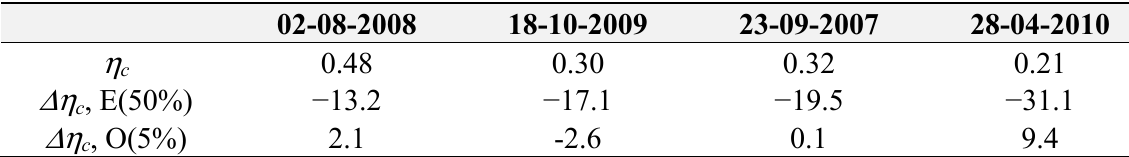
Table 3. The original values of the coarse volume mode fraction ( η selected days using the AERONET-retrieved size distribution and Equation (2) (top row). (%) caused by a 50% enhancement at 1.02 μ m wavelength (middle Uncertainties in η c row) and a 5% positive spectrally-independent offset (bottom row) are also